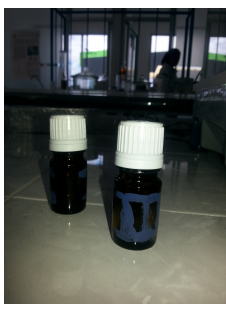
Figure A3. Numbered jars. Table A2. Bottle labels filled with (natural and synthetic) zeolites.